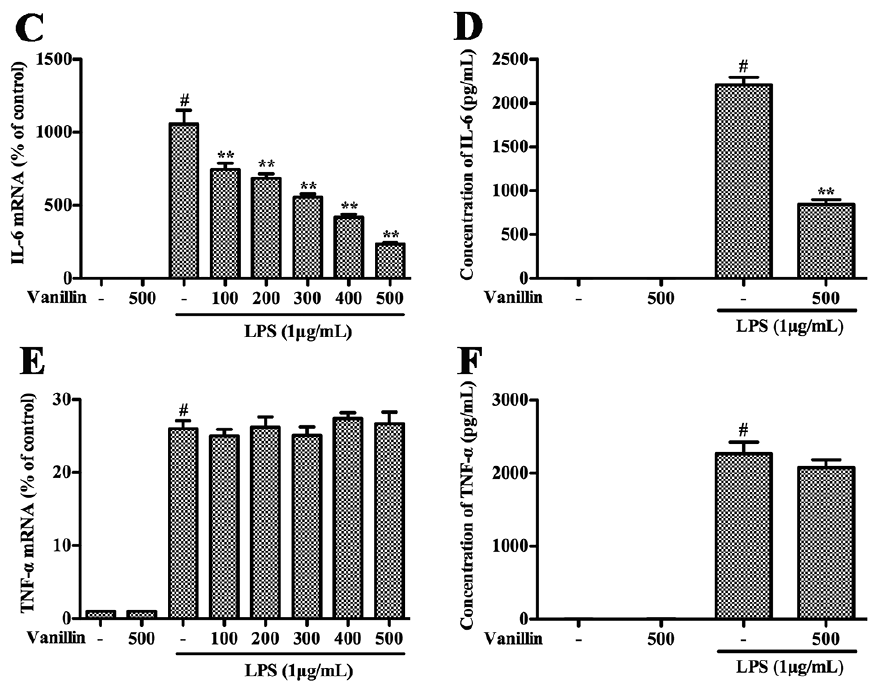
Figure 5. Effects of vanillin on LPS-induced proteins production and mRNA expression of pro-inflammatory cytokines in BV-2 cells were examined. The mRNA levels of IL-1β ( A ), IL-6 ( C ) and TNF-α ( E ) in BV-2 cells were examined by quantitative real-time PCR. Cells were pretreated with vanillin (100, 200, 300, 400 and 500 nM) for 1 h, and then incubated with LPS (1 µg/mL) for 4 h; the expression level of IL-1β ( B ), IL-6 ( D ) and TNF-α ( F ) was determined via ELISA. Cells were pretreated with vanillin (500 nM) for 1 h, and then incubated with LPS (1 µg/mL) for 12 h. # p < 0.01 vs. no treated group. ** p < 0.01 vs. the vanillin-untreated LPS-stimulated